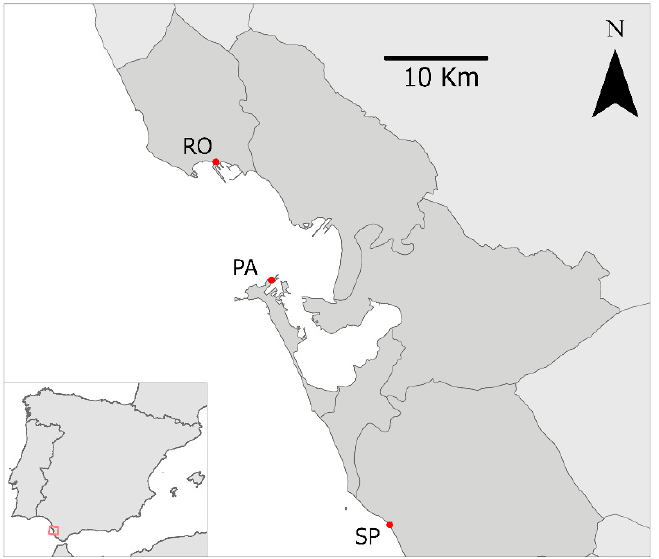
Figure 1. Map of the study area showing the three sampling marinas, Puerto de Sancti Petri (SP), Puerto de Rota (RO) and Puerto América (PA), in the Bay of Cádiz (Spain).